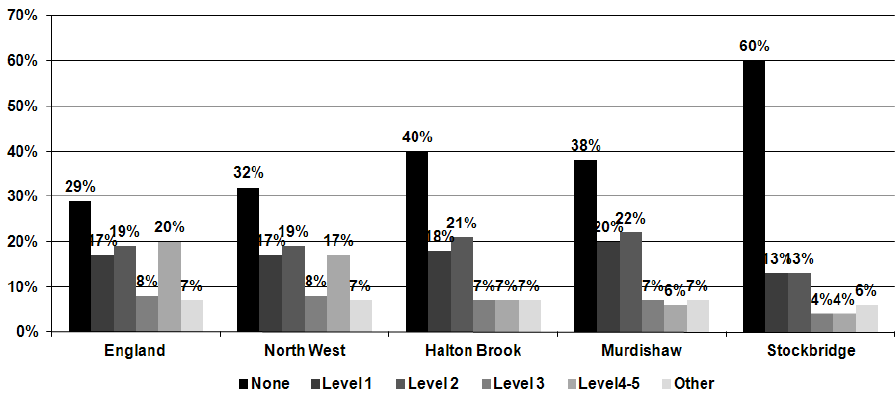
Figure 3. Qualifications held. Level 1 qualifications = 1 GCSE or equivalent; Level 2 qualifications = 5 + GCSE’s or equivalent; Level 3 qualifications = 2 + A’ Level’s or equivalent; Level 4 and 5 qualifications = First degree or equivalent; Other =